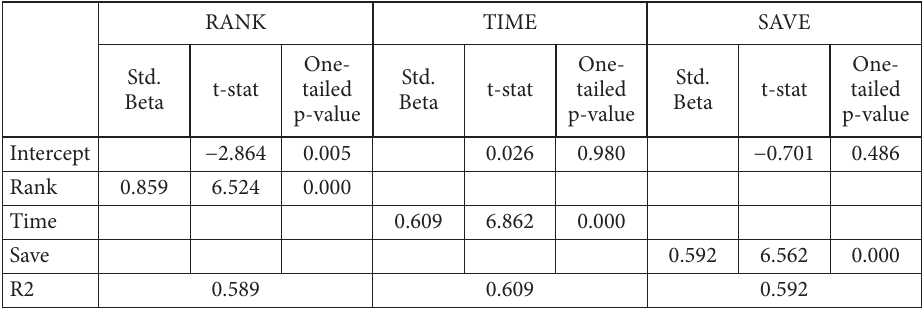
Table 5. Simple regression